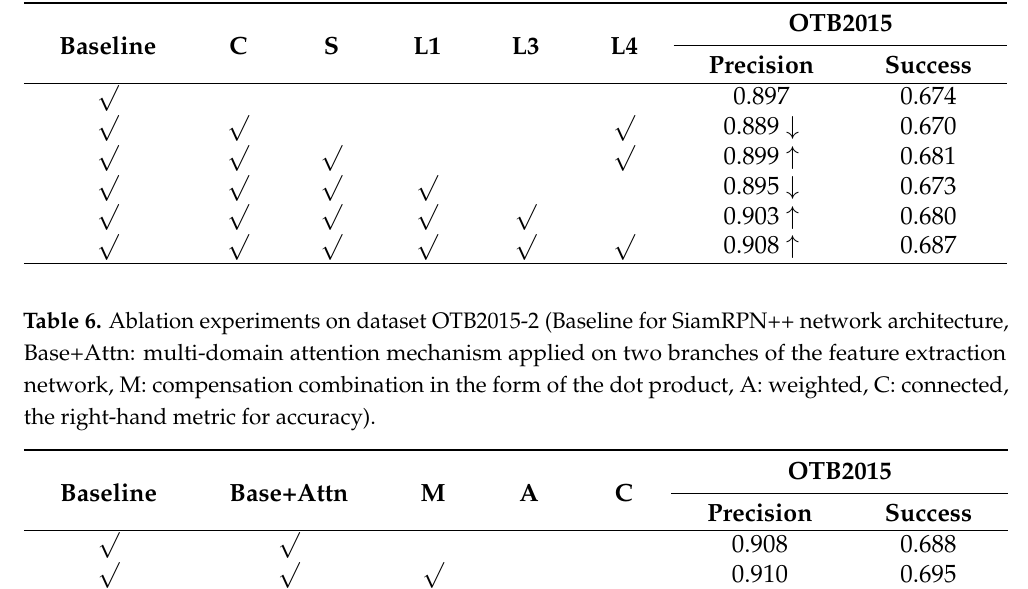
Table 5. Ablation experiments on dataset OTB2015-1 (Baseline for SiamRPN++ network architec- ture, C: channel attention, S: spatial attention,L1, L3, L4: ResNet network Layer1, Layer3, Layer4, respectively; right-hand metric is accuracy).